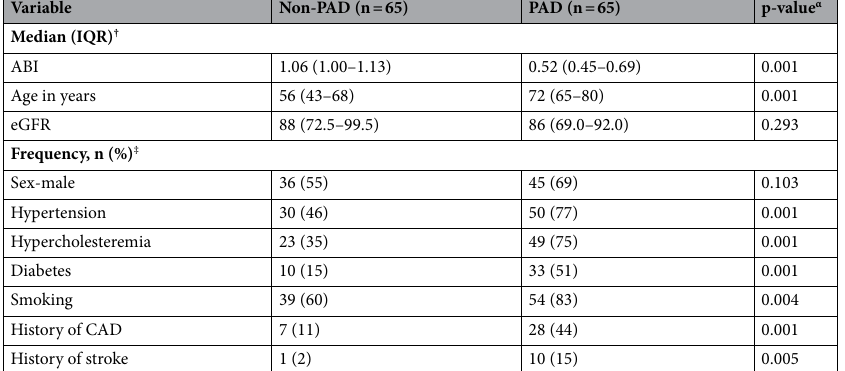
Table 1. Patient demographics and clinical characteristics. Medians and interquartile ranges (IQR) were calculated for continuous variables. Frequencies and percentages were calculated for categorical variables; all numbers were rounded up with zero decimal place. All p-values were rounded to three decimal places. ABI ankle brachial index, eGFR estimated glomerular filtration rate. α The significance of the difference between PAD and non-PAD groups. † Differences between groups were compared using Mann–Whitney test. ‡ Differences between groups were compared using chi-square test.